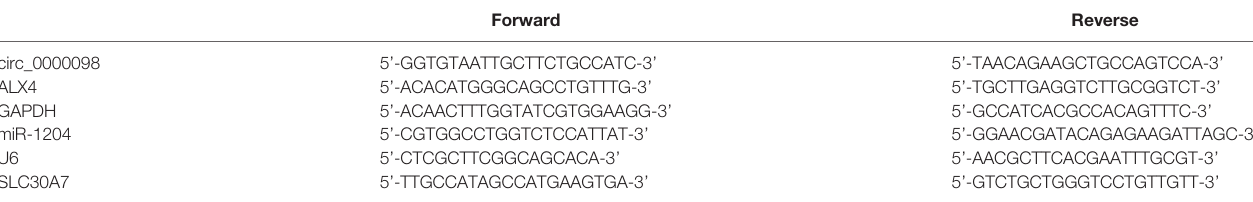
TABLE 1 | Primers used for